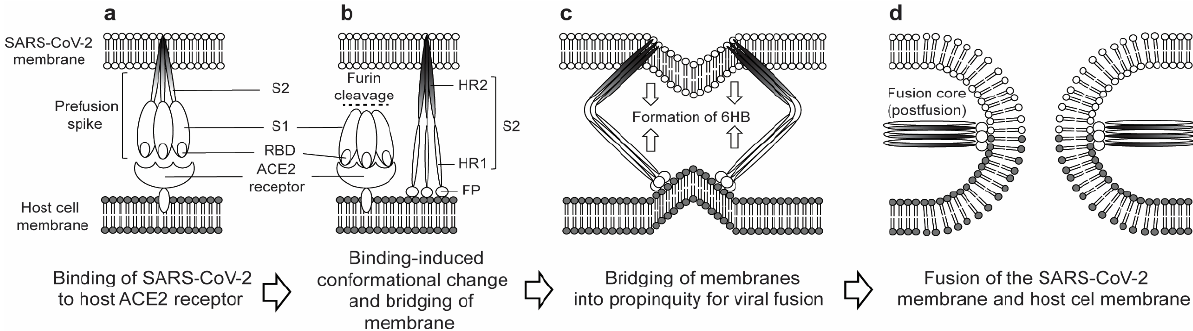
Figure 2. Schematic representation of ( a ) binding of SARS-CoV-2 prefusion spike (S) RBD to host ACE2 receptor, ( b ) cleavage of the S protein into the S1 subunit and the S2 subunit by furin, resulting in the fusion peptide (FP) of S2 being exposed and implanted into the target cell membrane, ( c ) formation of the 6-helical bundle (6HB) that bridges the membranes into propinquity for viral fusion, and ( d ) three HR1s and HR2s combining to form the fusion core (postfusion) to fuse the viral–host membrane.